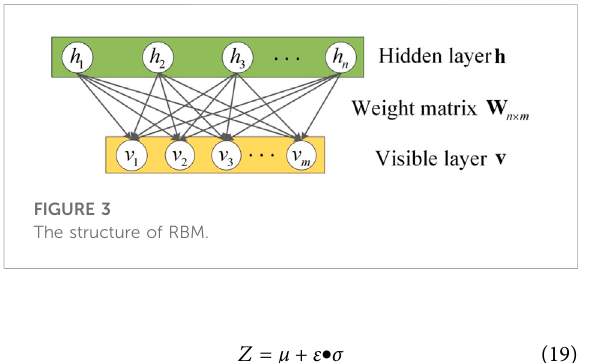
FIGURE 3 The structure of